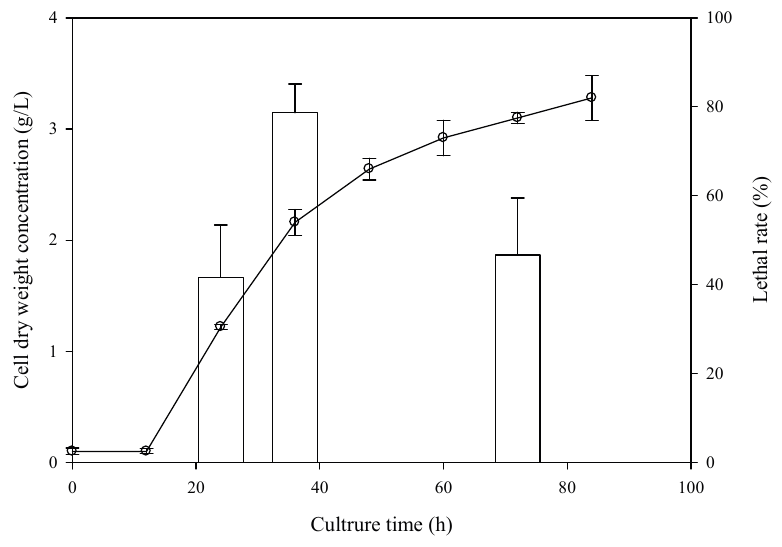
Figure 1. Effect of sampling time on the lethal rate of C. cohnii irradiated by atmospheric and room temperature plasma (ARTP): the line was the growth curve of C. cohnii for the mutagenesis; the columns were the lethal rate of C. cohnii sampled at 24, 36, and 72 h treated by ARTP with a radio-frequency (RF) power input of 150 W for 90